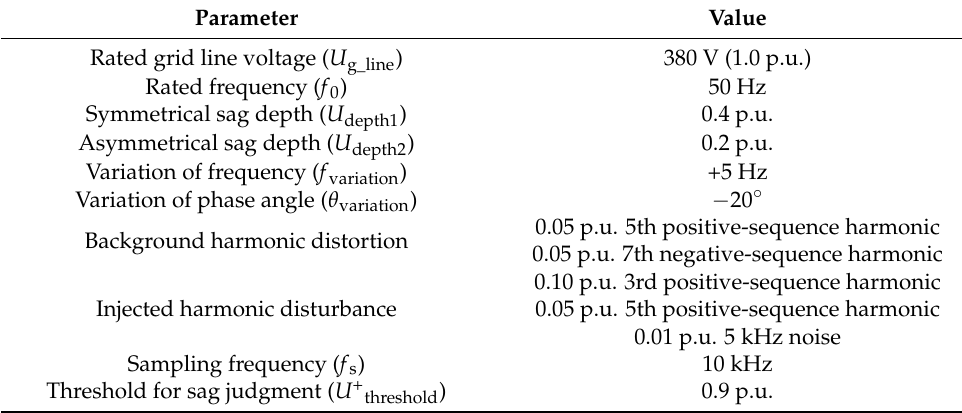
Table 1. The main Table 1. The main parameters.